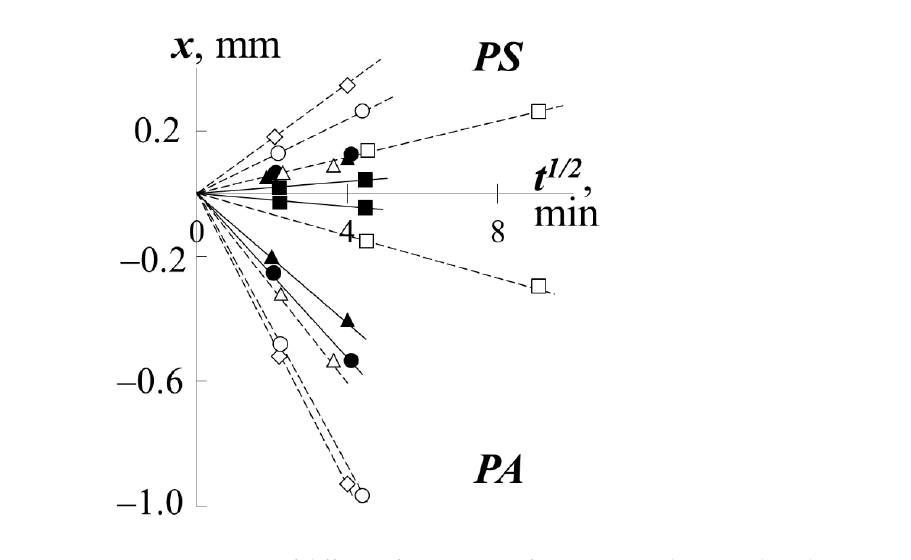
Figure 4. Kinetics of diffusion fronts motion for systems with PS-1 (white dots) or with PS-2 (black dots) when they mixed with PMA (squares), PEA (triangles), PBA (circles), PEHA (rhombuses) at 433 K.